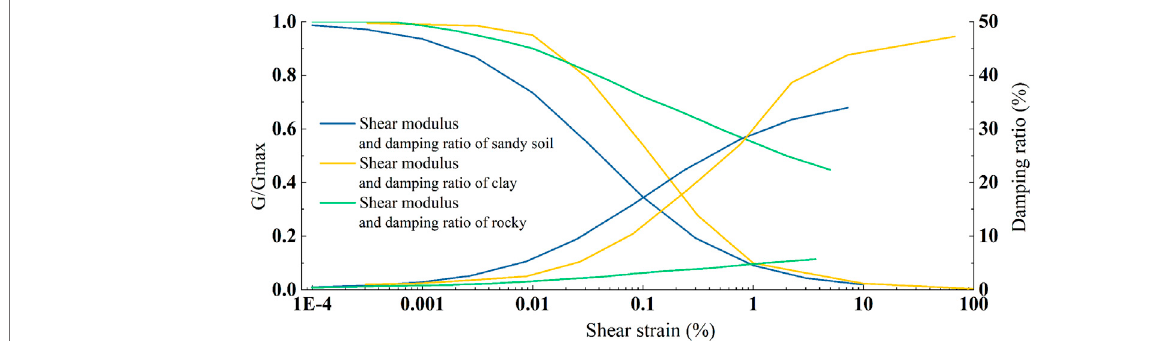
FIGURE 4 | The variation in the shear modulus and damping ratio of the clay, the sandy soil, and the rocky soil with the shear strain.